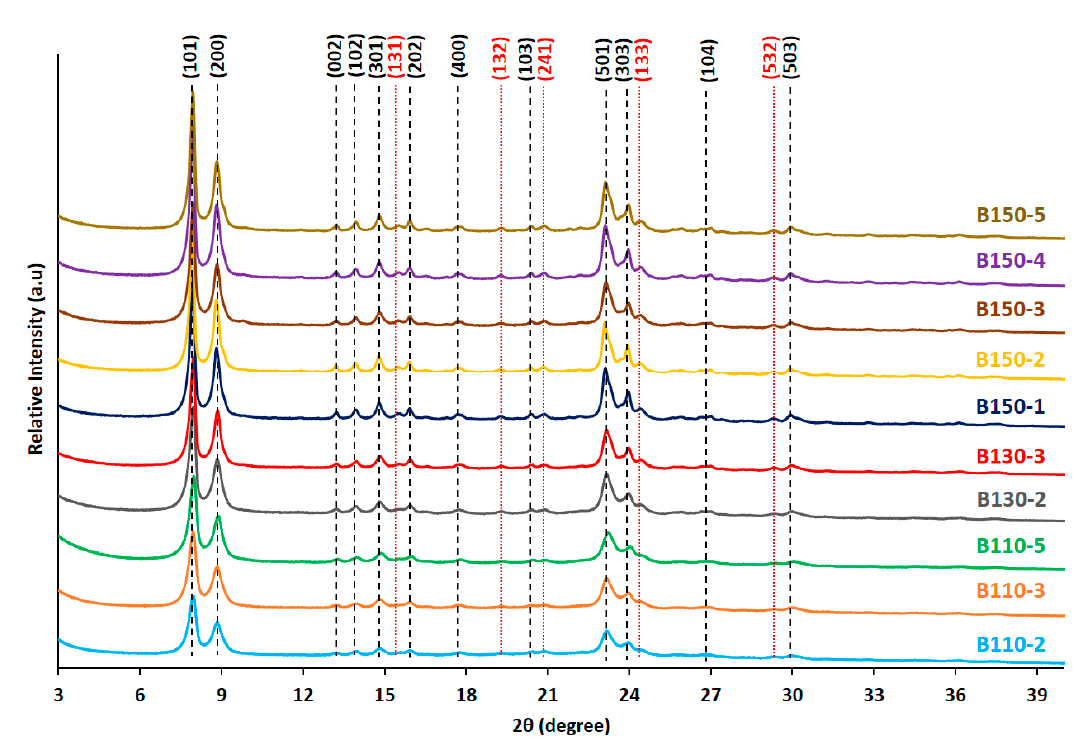
Figure 1. X-ray di ff raction (XRD) patterns of calcined silicalite-1 beads (B-T( ◦ C)-t(days)) obtained at Figure 1. X ‐ ray diffraction (XRD) patterns of calcined silicalite ‐ 1 beads (B ‐ T(°C) ‐ t(days)) obtained at di ff erent temperatures and treatment different temperatures and treatment times.